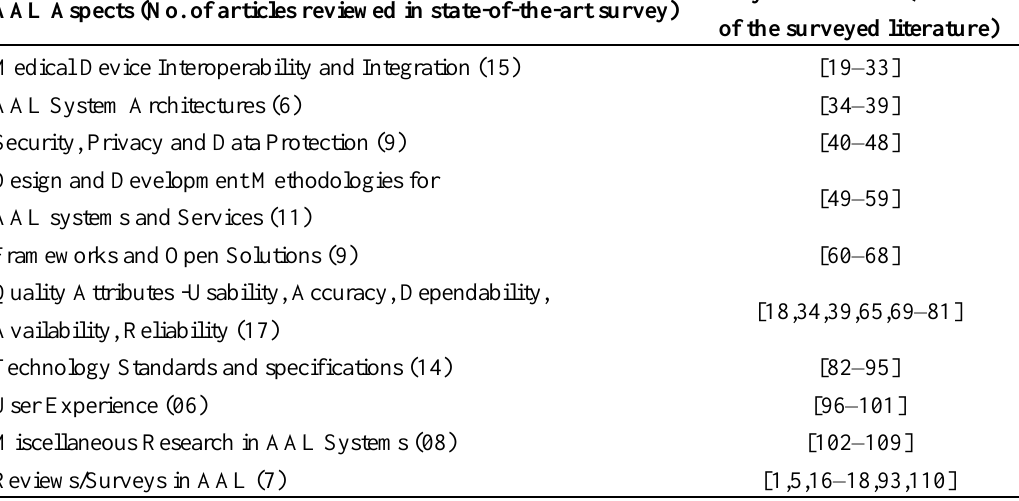
Table 1. Main aspects of AAL systems and surveyed literature.